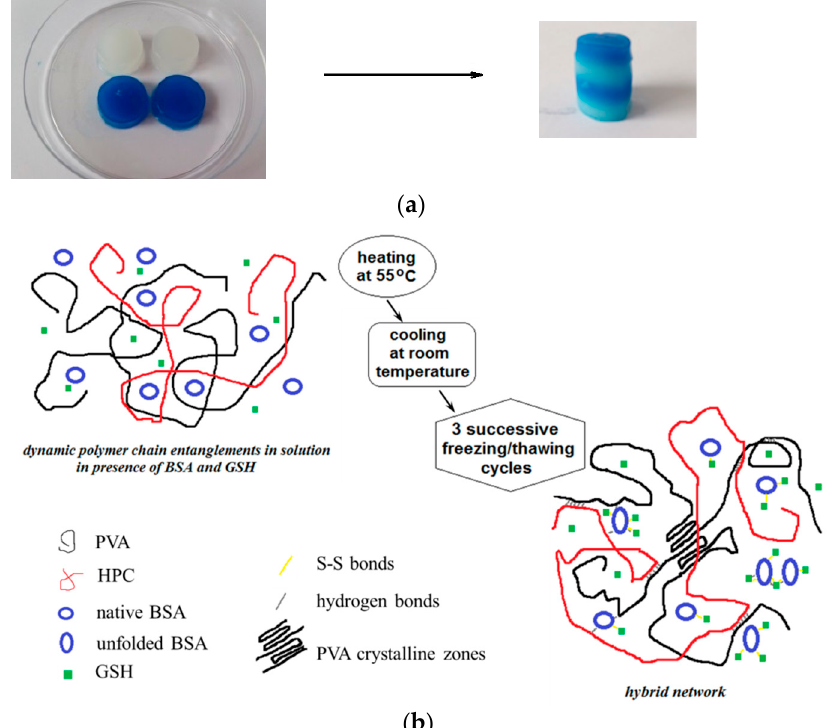
Figure 5. ( a ) Macroscopic image showing the self-healing behavior of hybrid hydrogels ( w BSA = 0.5). ( b ) Schematic presentation of hybrid hydrogel formation.